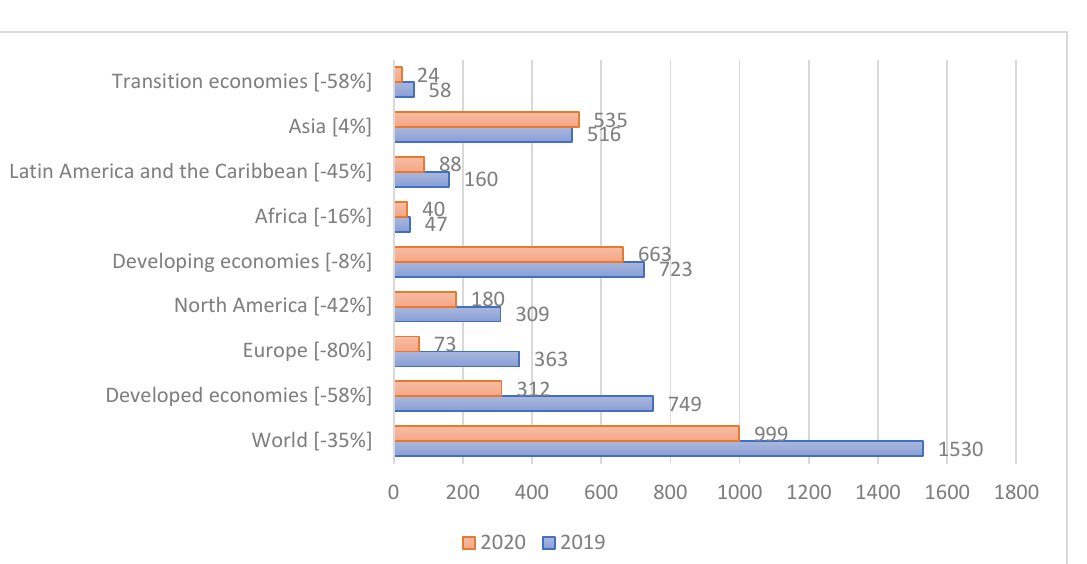
Figure 2. World trends in FDI as a percentage of GDP.